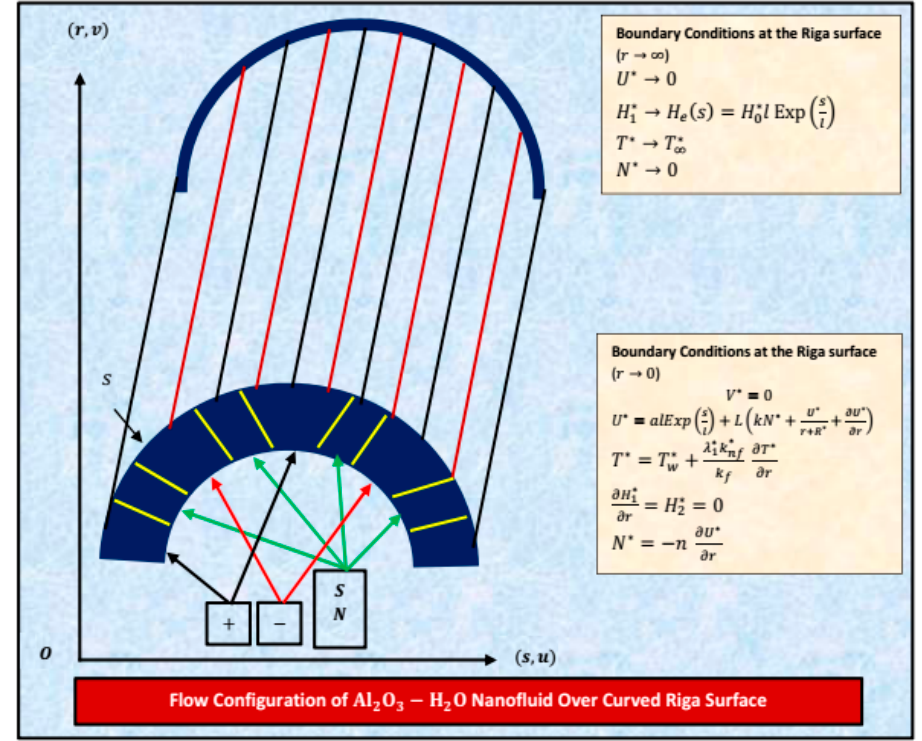
Figure 15. Flow of Al 2 O 3 –H 2 O over curved Riga surface.